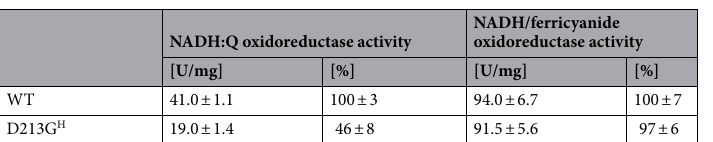
Table 2. NADH:decyl-Q and NADH/ferricyanide oxidoreductase activity of complex I and the D213G H variant in detergent. Data were derived from three biological replicas; each replica was measured in triplicates. The standard deviation of the measurement is shown.